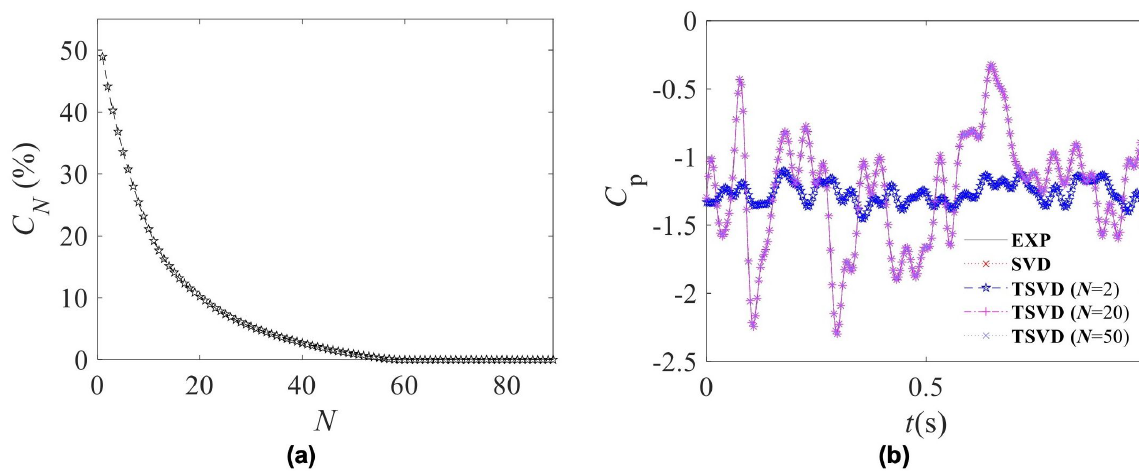
Figure 15: Example of C N trend (a) and pressure coeflcients series by TSVD for the case of geometry G 1 , θ = 0 ∘ (b)